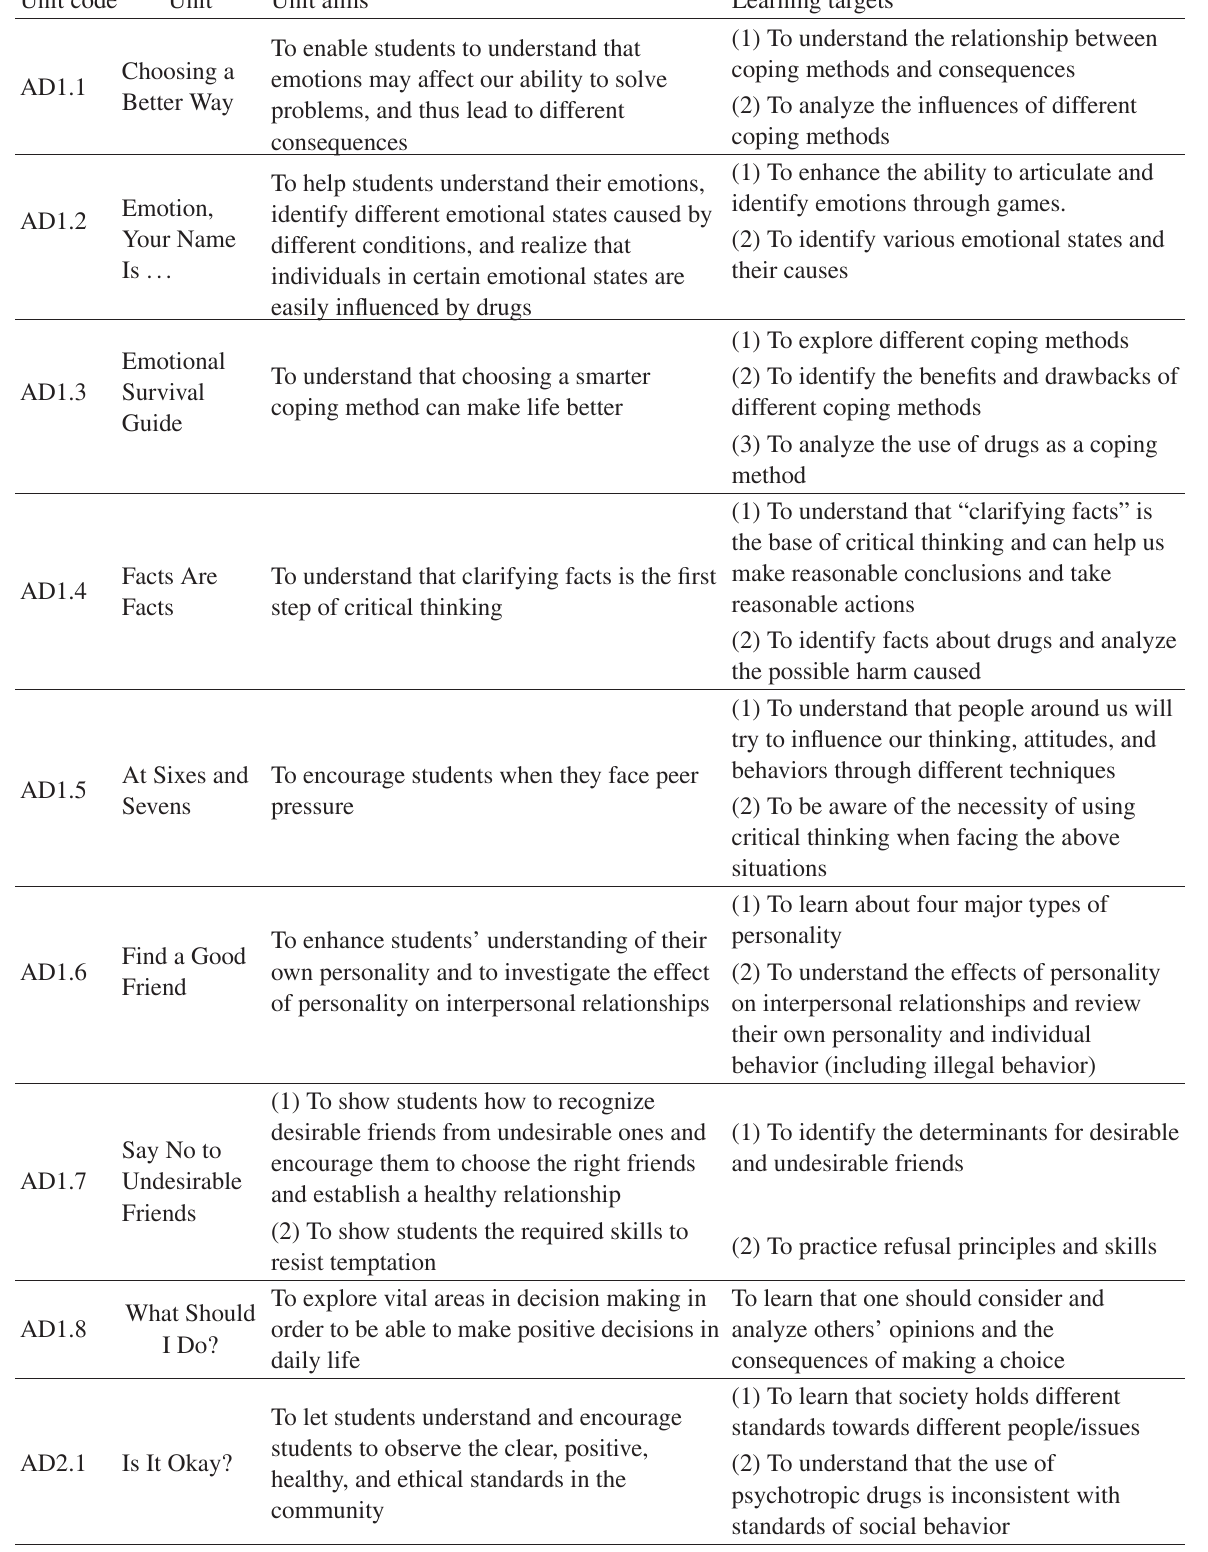
TABLE 2: The 20 drug-education units in the P.A.T.H.S. Extension